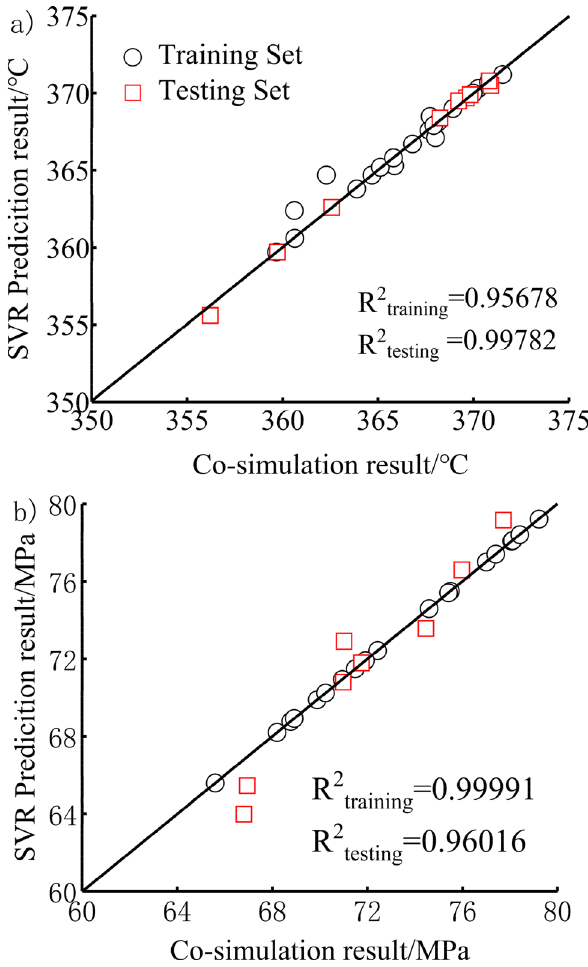
Figure 8. Regression model of ( a ) maximum temperature of piston and ( b ) maximum thermal stress of